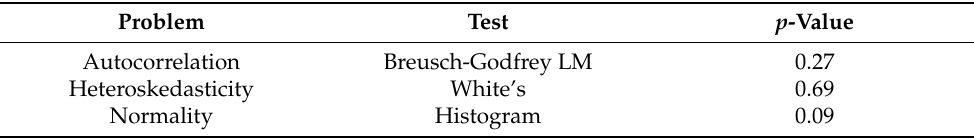
Table 6. Diagnostic